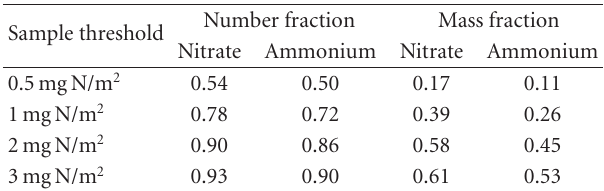
Figure 5: Annual budgets for nitrogen wet deposition through nitrate. Wide bars: solid precipitation season; narrow bars: liquid precipitation